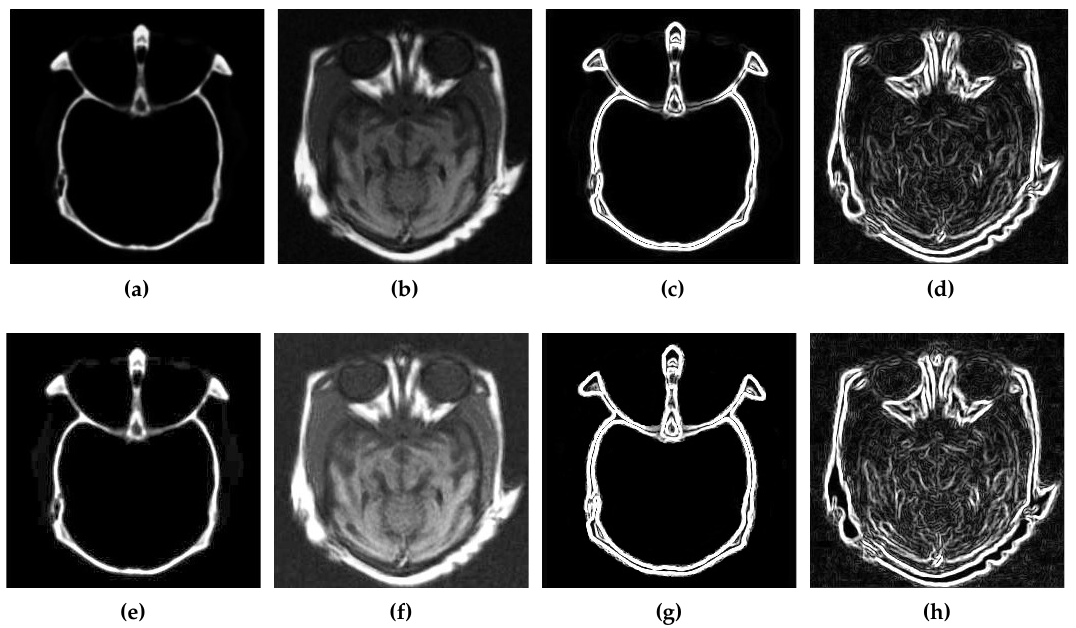
Figure 3. Edge detection results, where ( a , b ) are the original source images, ( c , d ) represent the gradients of ( a , b ) using the Sobel method, ( e , f ) shows the images with enhanced contrast using BIMEF, and ( g , h ) represent the gradients of ( e , f ) using the Sobel